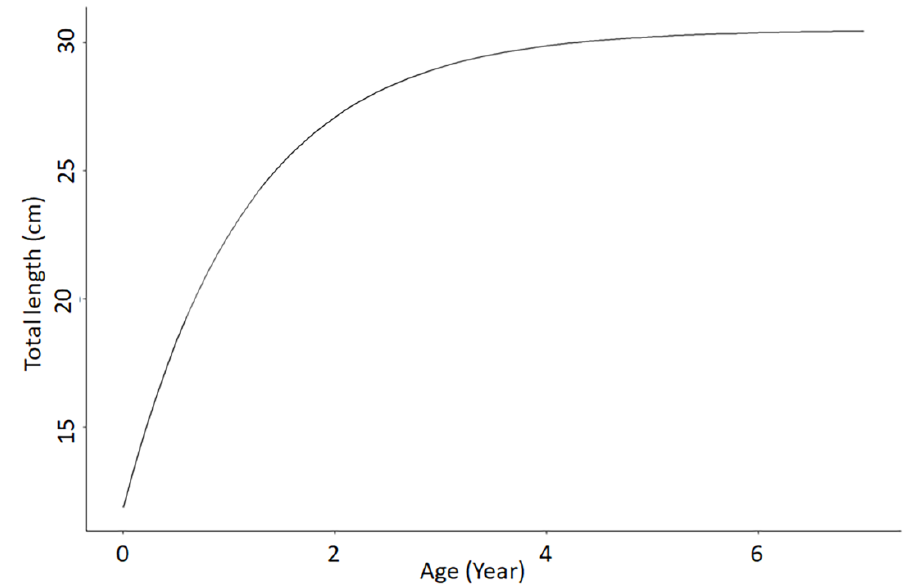
Figure 4. The Sardina pilchardus von Bertalanffy growth curves fitted to monthly mean length-at-age data in Northern Senegalese waters. Data collected in 2015 (987 specimens), 2007 (2153 specimens), and 2008 (811 specimens).